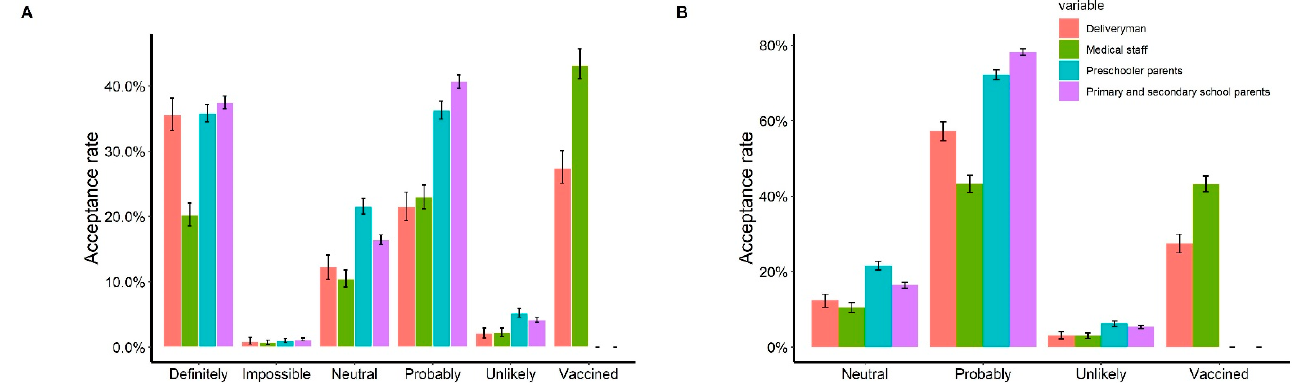
Figure 6. Vaccine acceptance of four key populations. ( A ) The acceptance rate of four key populations; ( B ) the acceptance rate of four key populations. We combined the options “definitely” and “probably” into probably, and combined “impossible” and “unlikely” into unlikely. For each plot, the read bar represents the acceptance rate of deliveryman, the green bar represents the acceptance rate of medical staff, the blue bar represents the acceptance rate of preschoolers’ parents, and the purple bar represents the acceptance rate of primary and secondary school students’ parents; the tentacles on the bars represent averaged results of bootstrap simulations with 95% confidence inter- val.